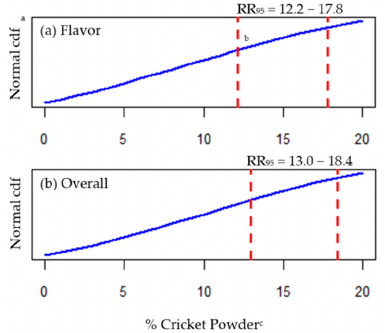
Figure 5. Rejection range 95% (RR 95 ) for cricket powder in whole-wheat snack crackers. ˆ RR 95 was estimated, from a probit regression model, as the range of x -values (% cricket powder) bounded by a 95% confidence interval around the RTT 25 (% cricket powder associated with 25% rejection) for flavor and overall acceptance. a Normal cumulative distribution functions (cdf) were based on probit regression models, where the left-tailed area under the blue line represents the estimated probability of rejection (acceptability = “no”) as a function of % cricket powder. b Red dashed vertical lines